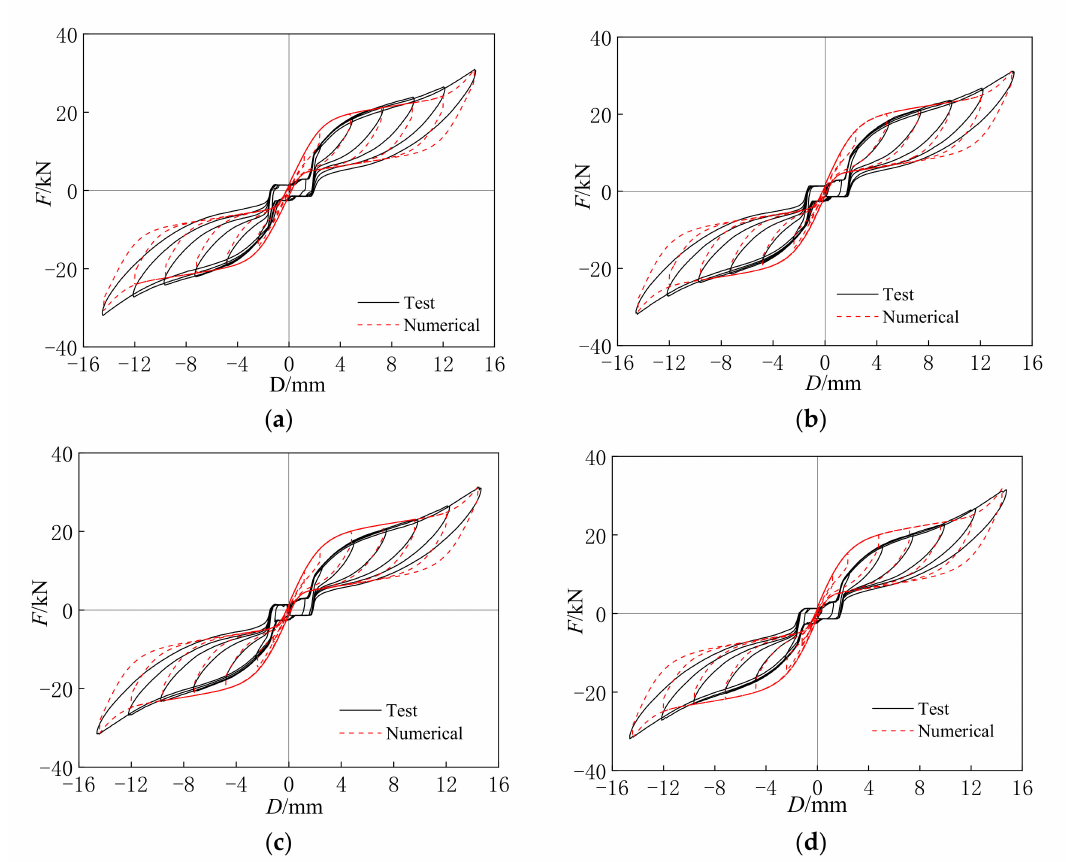
Figure 14. ( a ) SCB-12-0; ( b ) SCB-18-0; ( c ) SCB-24-0; ( d ) SCB-36-0. Comparison between test and numerical hysteresis curves under different loading